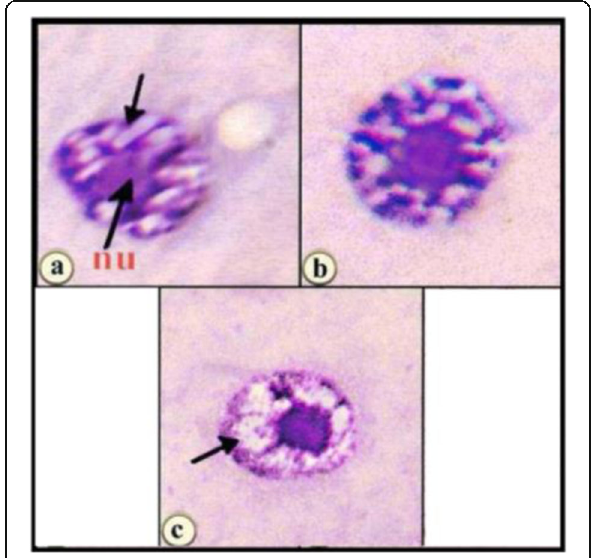
Fig. 8 Morphological changes in oenocytoids ( x = 1600). a Normal: oenocytoid is slightly round with round, large, and approximately centric nucleus (arrow). b 40 Gy: increase in the cell size. c 100 Gy ( nu indicates the hemocyte